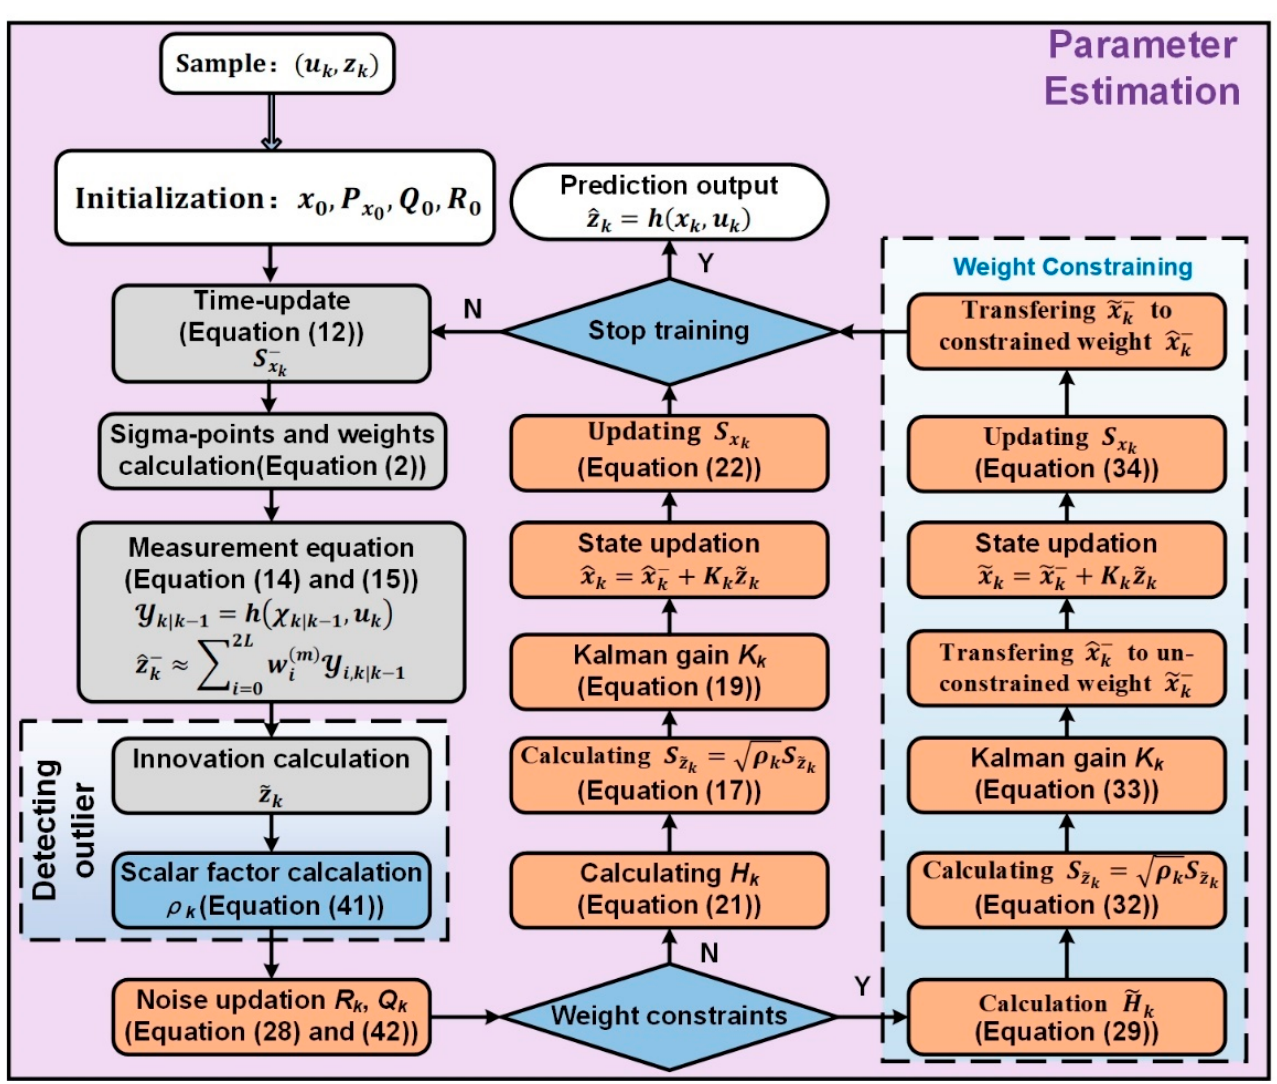
Figure 2. Schematic diagram of the proposed Elman-SR-UKF method for parameter estimation.